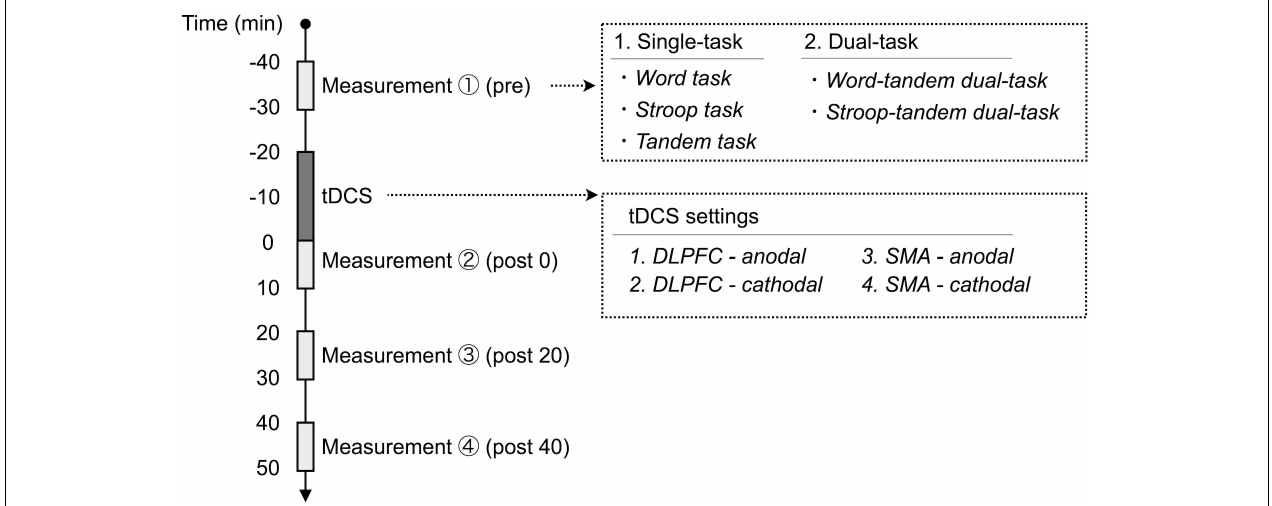
FIGURE 2 | Experimental procedures. Each subject participated in four experimental sessions with different stimulation parameters of transcranial direct current stimulation (tDCS). We measured single- and dual-task performances before and after applying tDCS. Each task performance was assessed before applying tDCS (pre), immediately after applying tDCS (post 0), 20 min after applying tDCS (post 20), and 40 min after applying tDCS (post 40). DLPFC, dorsolateral prefrontal cortex; SMA, supplementary motor